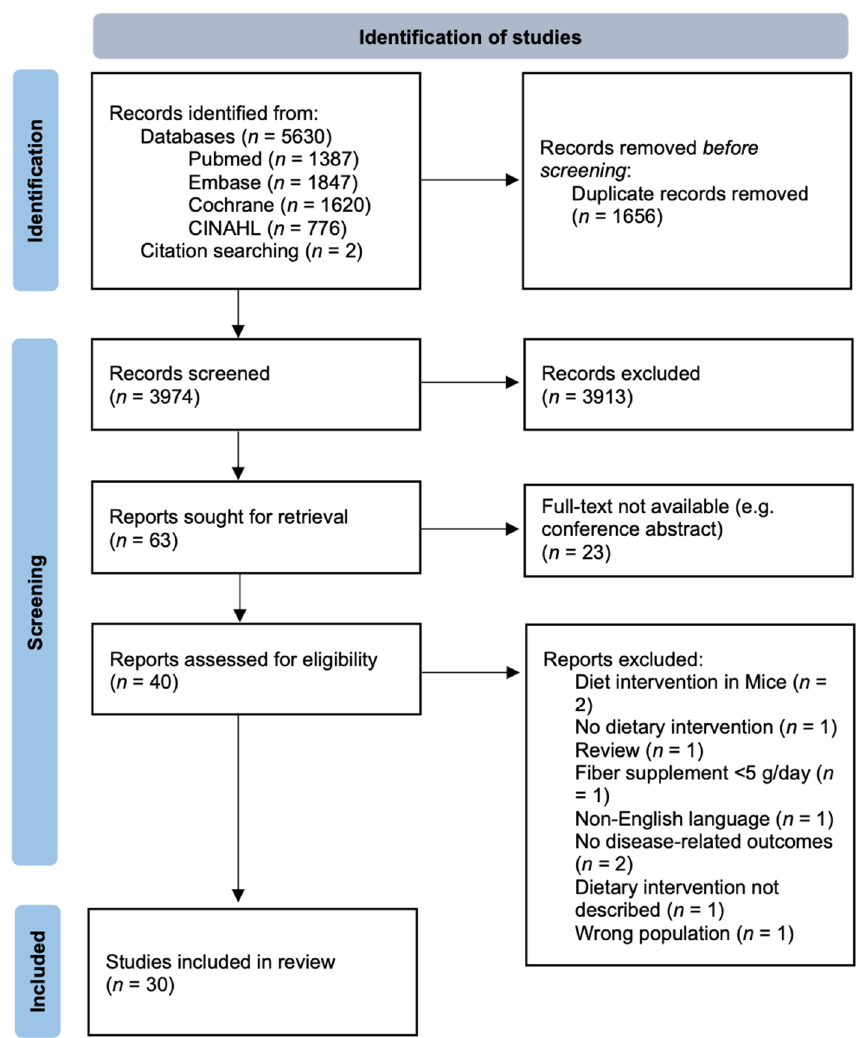
Figure 2. Flow diagram of the systematic literature search for dietary intervention, chronic inflam- matory disease, and microbiome based on the PRISMA method